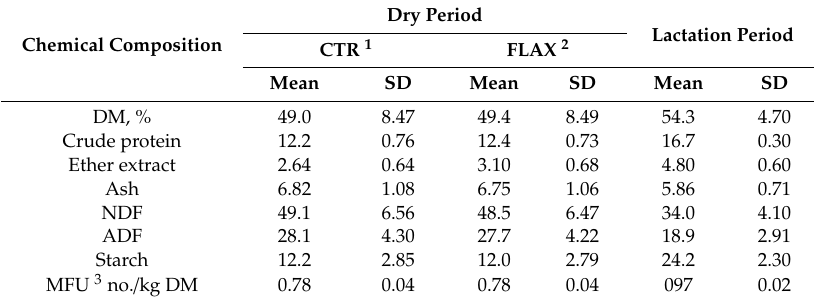
Table 1. Chemical composition (mean ad standard deviation, SD) of control (CTR) and flaxseed supplemented (FLAX) diets used during the trial expressed as % on DM basis.